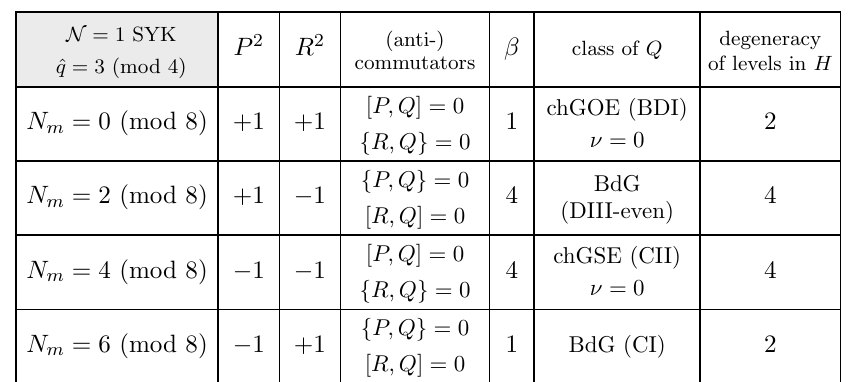
Table 4 . Symmetry classi(cid:12)cation of Q in the N = 1 SYK model for ^ q = 1 (mod 4). For the block structure of each class we refer to table 1.